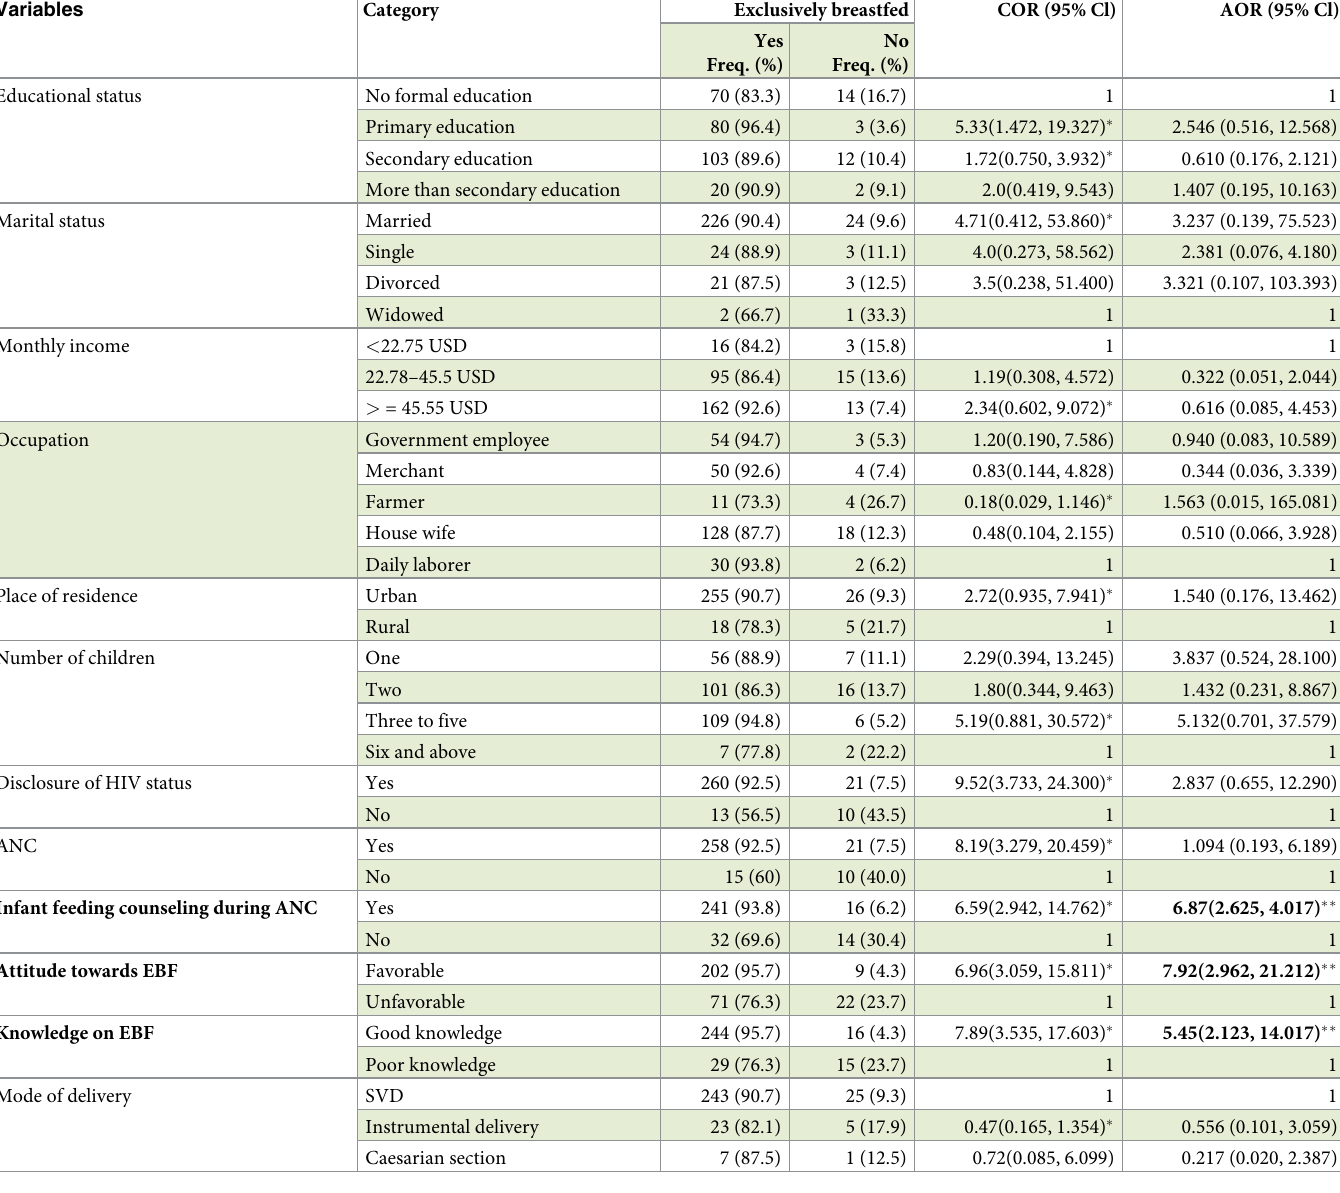
Table 4. Determinants of exclusive breastfeeding practice of HIV positive women visiting public hospitals, Tigray, Northern Ethiopia, 2016 (N = 304). Variables Category